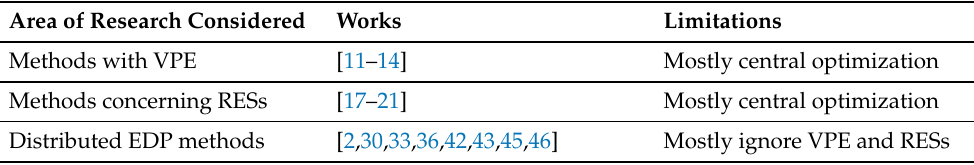
Table 1. Area of research considered in existing